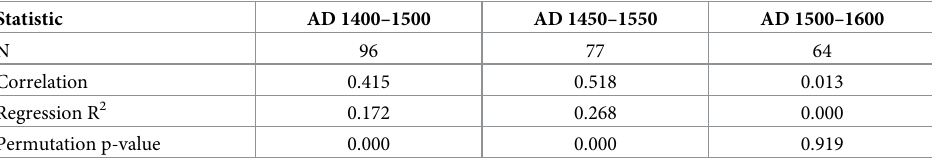
Table 5. Correlations of site-level geodesic similarity and BR brokerage